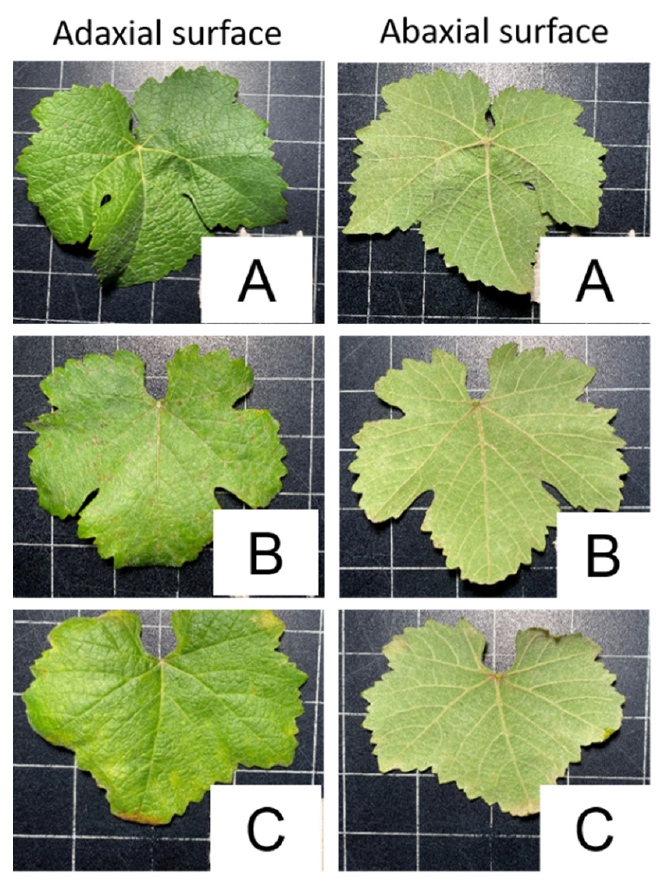
Figure 5. Disease development stages from healthy ( A ) to visible spots ( B , C ) on the adaxial ( left ) and abaxial ( right ) sides of grapevine leaves cv. Pinot Meunier.